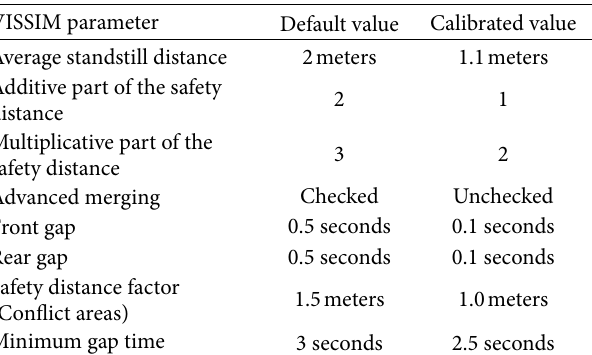
Table 5: VISSIM calibration